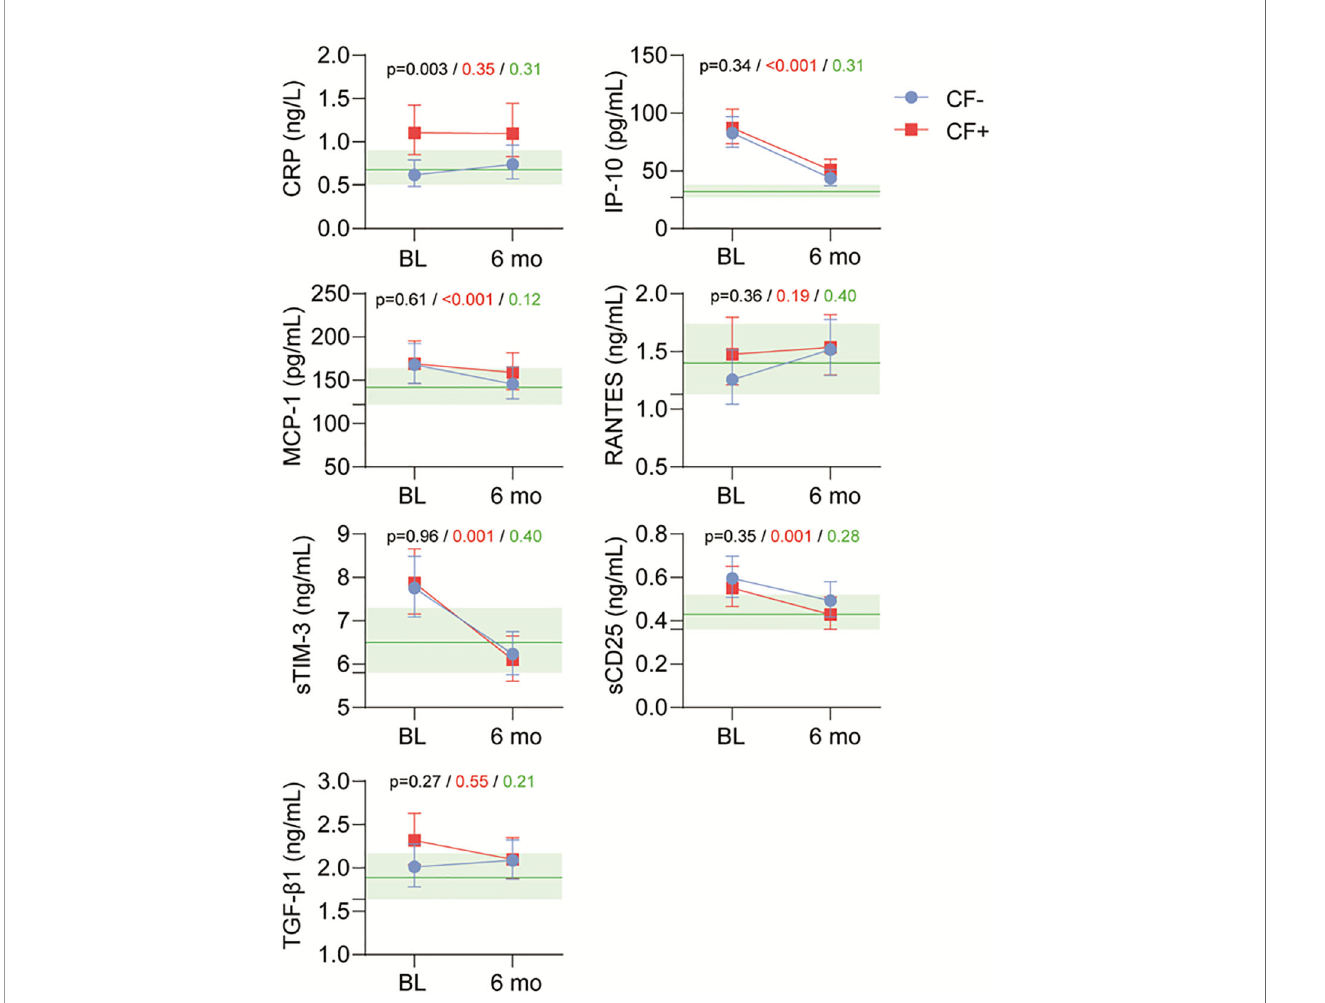
FIGURE 3 | Plasma levels of cytokines and in fl ammatory markers in healthy controls (HC) and EBV patients with and without fatigue (CF+ and CF-, respectively) at baseline and after 6 months. Black p-value group effect, CF+ vs CF- irrespective of time. Red p-value time effect irrespective of group. Green p-value interaction of time vs group. Levels of controls with 95% CI marked in light green.